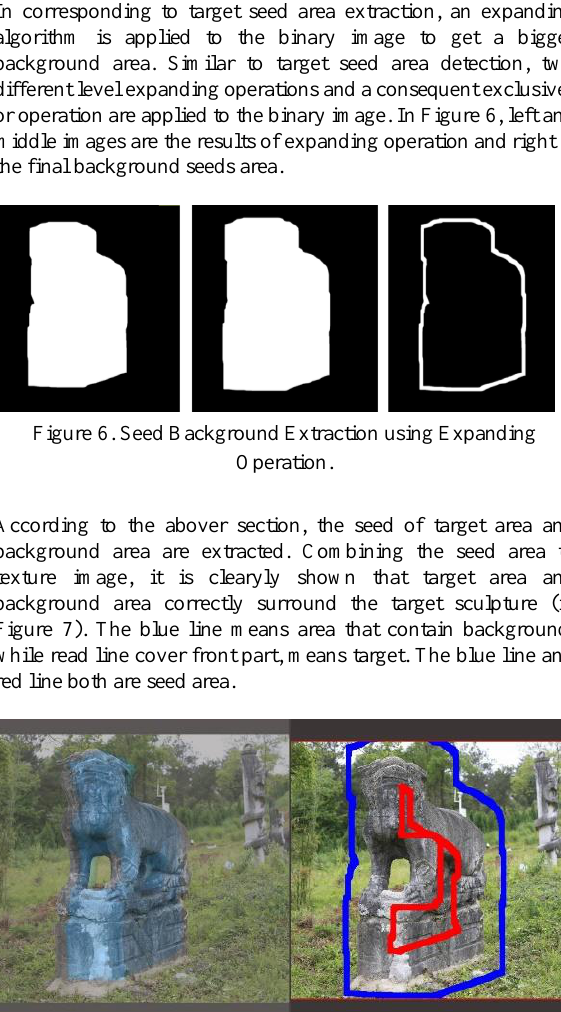
Figure 7. Target seed and background seed surround the target sculpture.